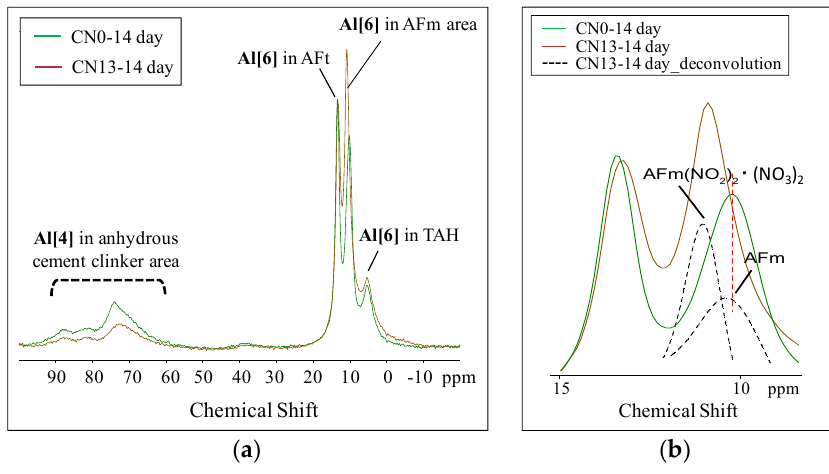
Figure 10. 27 Al NMR spectra of CN0 and CN15 (Day 14). ( a ) Total; ( b ) AFm